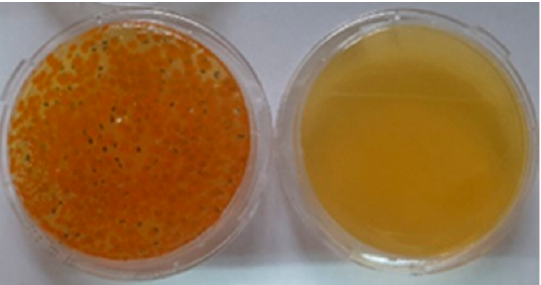
Figure 9. CT3P agar imprint plates of the face and back of the 3D-woven fabric, and bacterial colonies after face imprinting of the 3D-woven fabric.